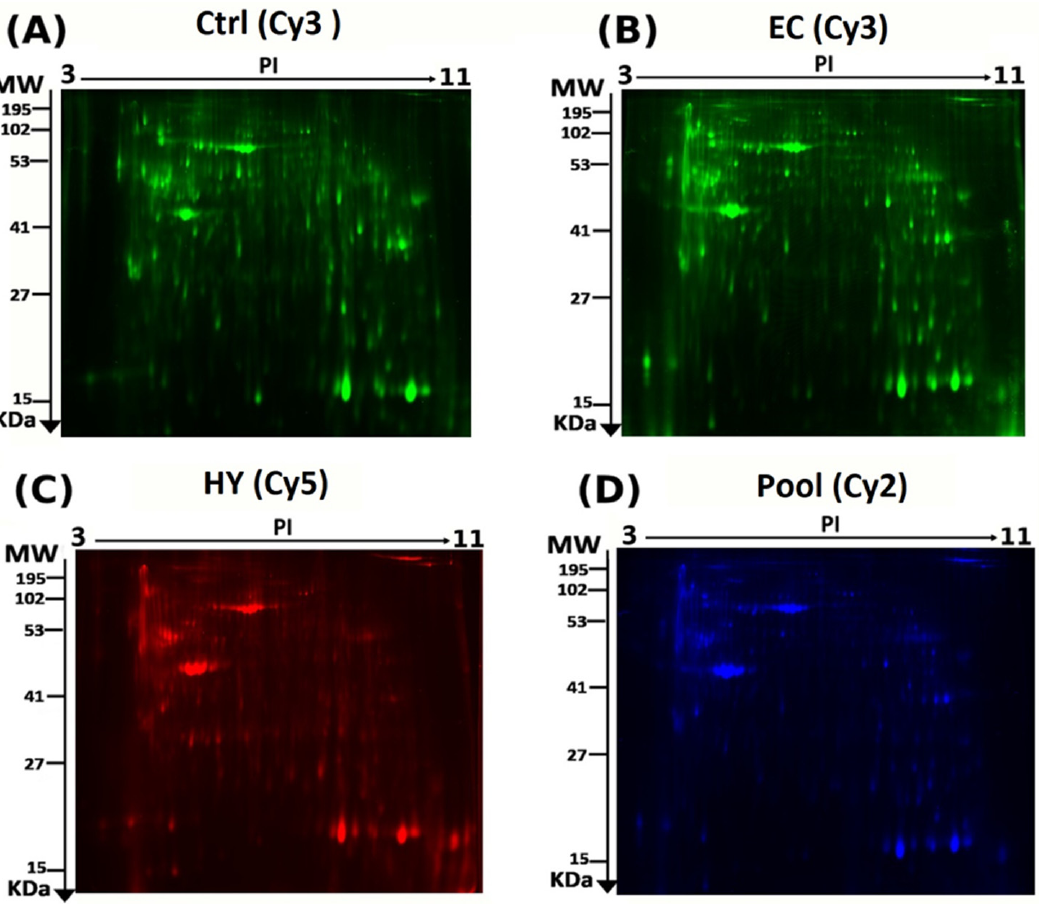
Figure 1. Representative fluorescent protein profiles obtained using 2D-DIGE containing: ( A ) Ctrl (sample no: Ctrl1) labeled with Cy3 (green), ( B ) EC (sample no: EC2) labeled with Cy3 (green), ( C ) HY (sample no: HY2) labeled with Cy5 (red), and ( D ) pooled internal control labeled with Cy2 (blue).